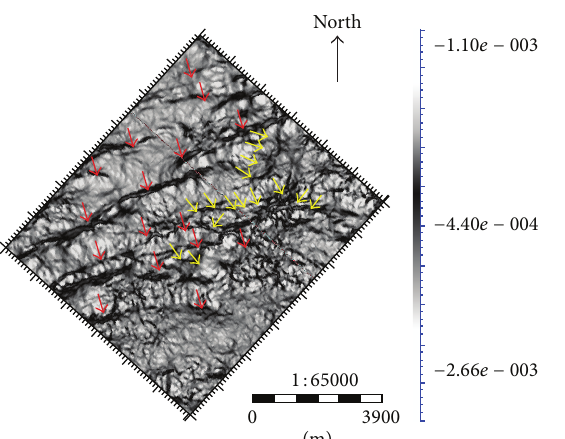
Figure 4: The substructure along the target layer in curvature attributes.